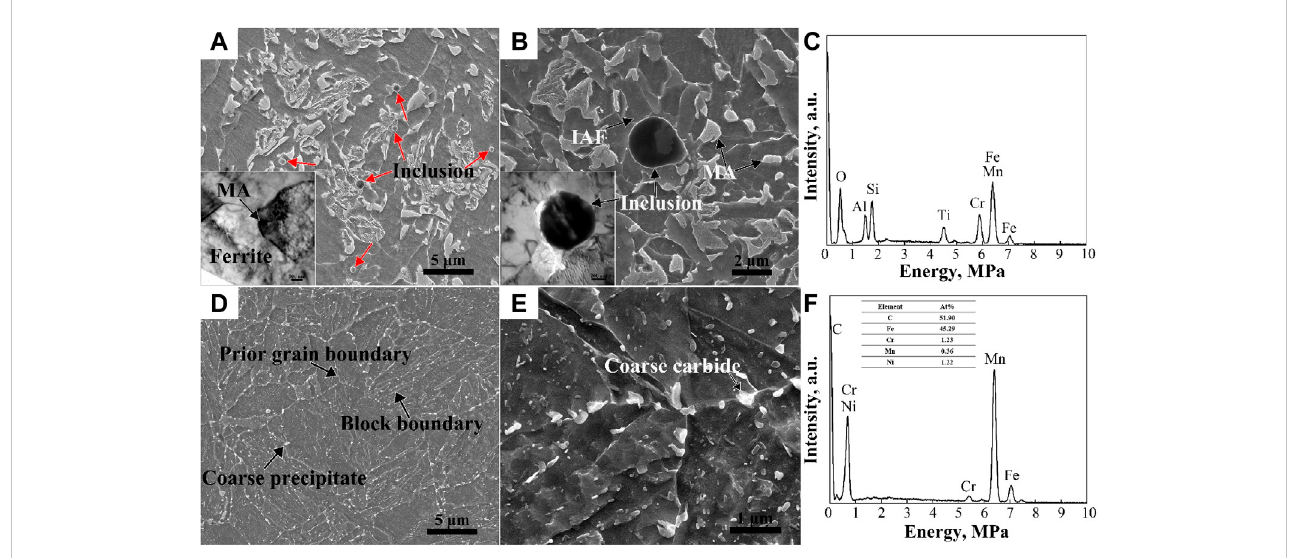
FIGURE 9 SEM morphologies of WM (A,B) and BM (D,E) at different magni fi cation. The corresponding EDS maps of the inclusion (C) and coarse carbide (F) are marked by an arrow in (B) and (E) , respectively. TEM bright fi eld images are shown in the insets of (A,B) .